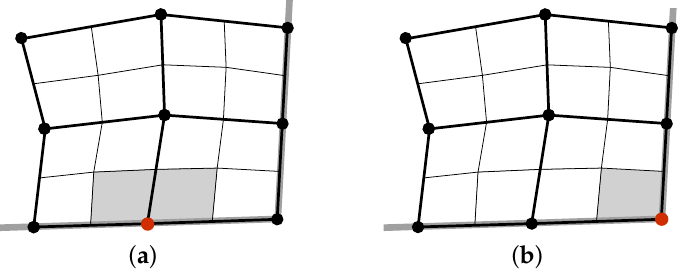
Figure 2. Control volumes for vertex-centered scheme at ( a ) boundary and ( b ) a